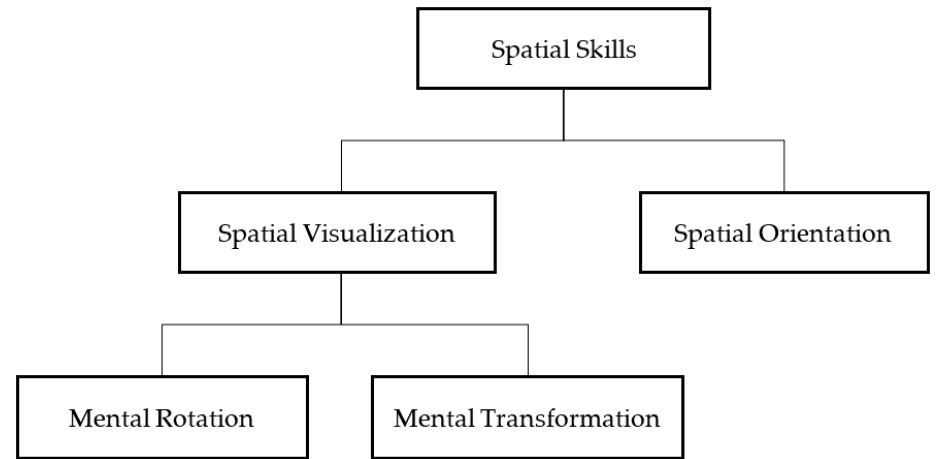
Figure 1. Classification of spatial skill [15].